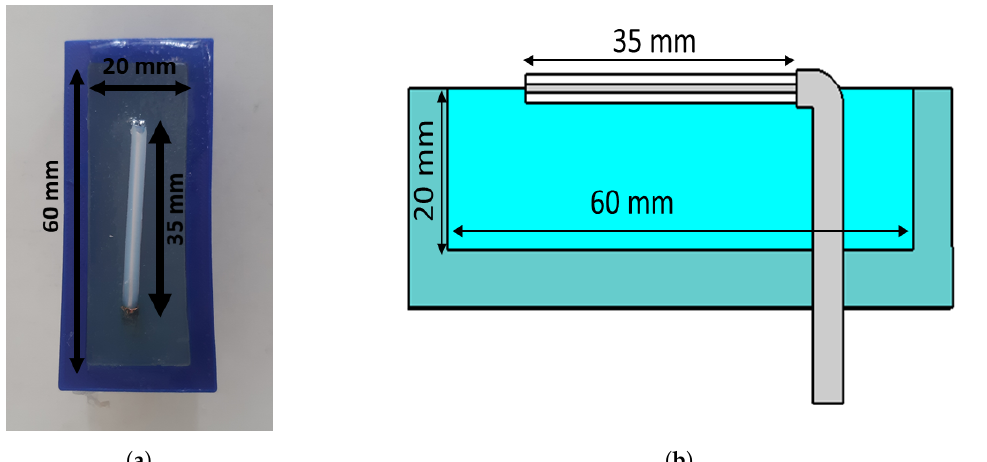
Figure 3. Monopole antenna with cup full of gel: ( a ) top view of antenna; ( b ) side view of antenna.